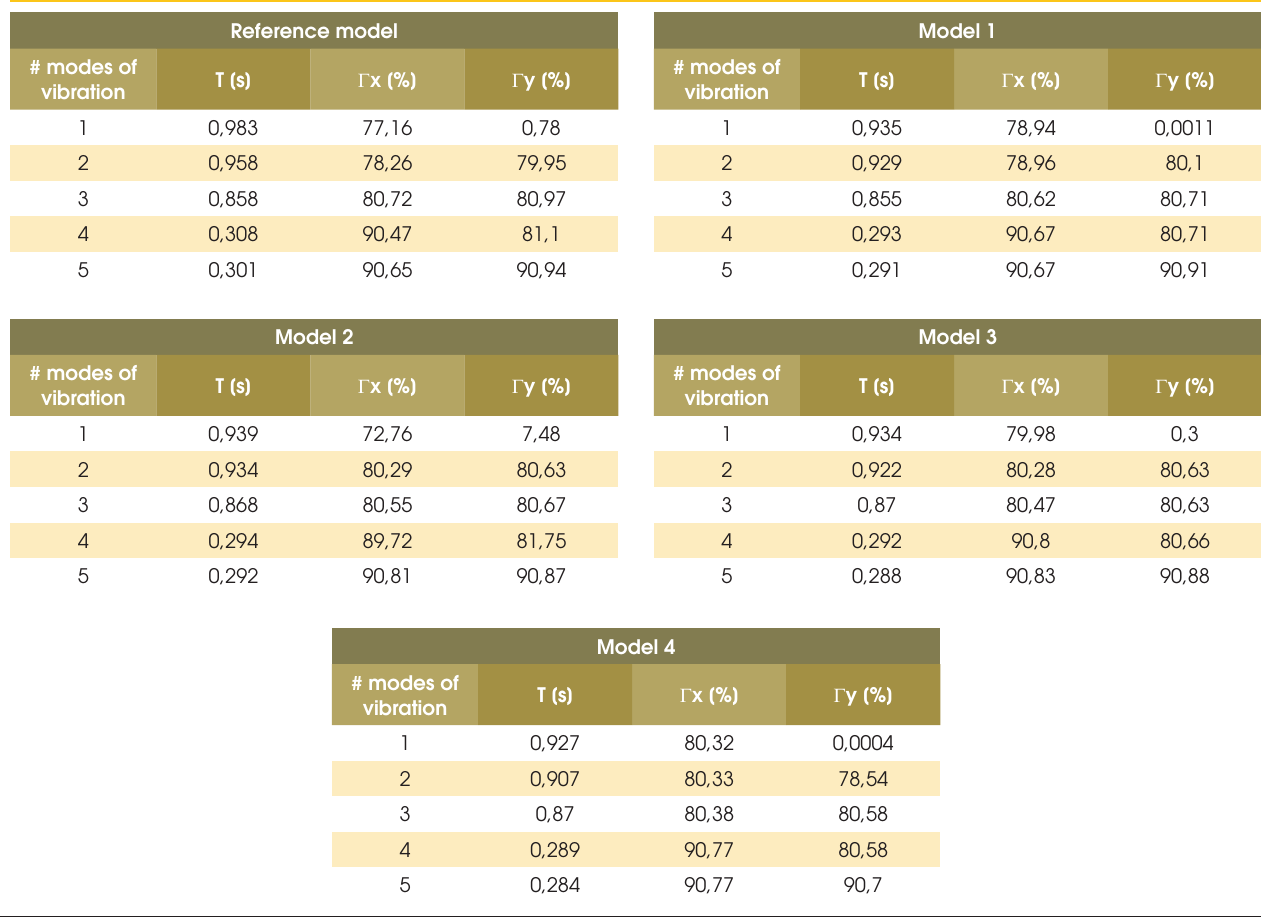
Table 1 – Natural frequencies and associated modes of vibration to each